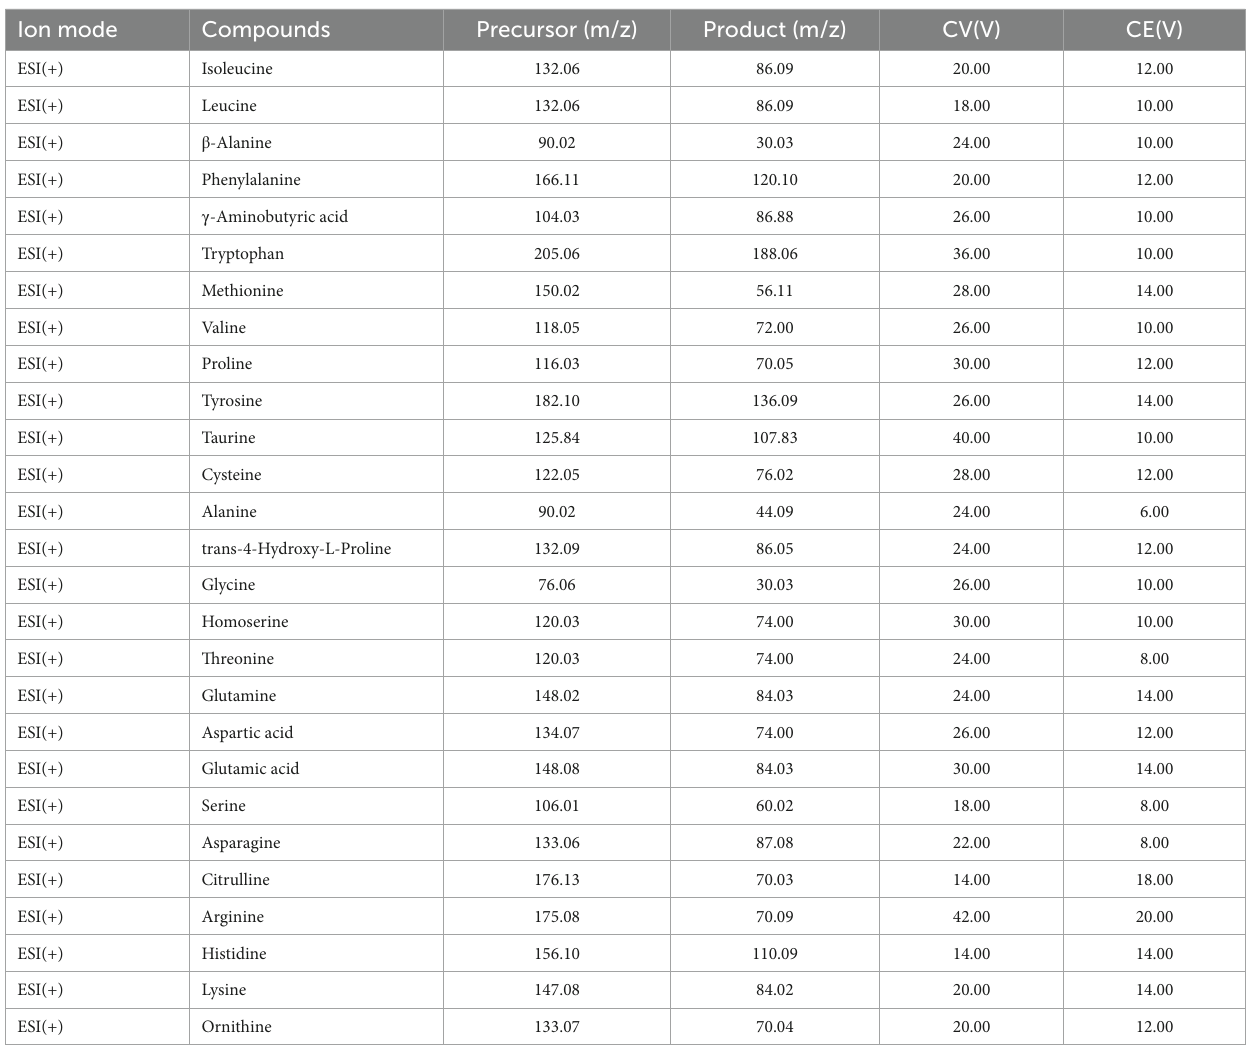
TABLE 2 Mass spectral data of the 27 target amino